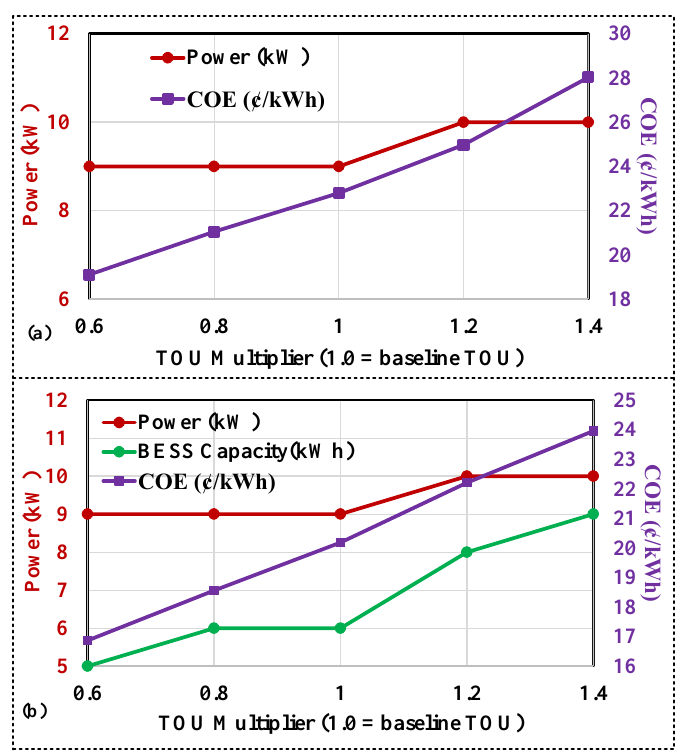
Figure 10. Sensitivity analysis for the impact of TOU rates using Option 2: ( a ) PV only system; ( b ) PV-BESS system.